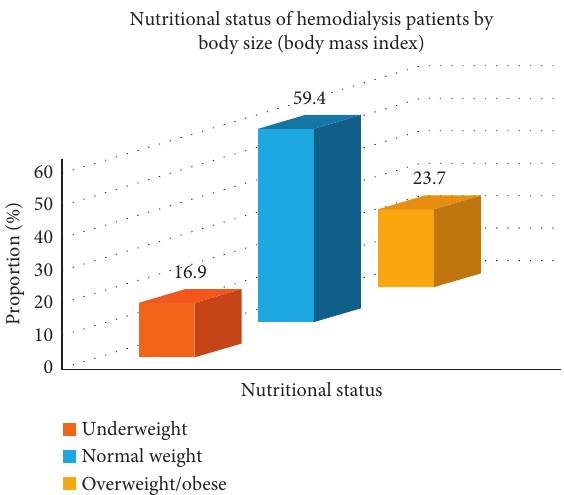
Figure 2: Nutritional status of hemodialysis patients by body size (body mass index).